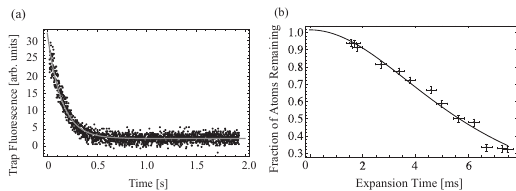
Figure 27. ( a ) Measurement of the optical molasses decay time. A fit to a decaying exponential gives a 1/ e time constant of 0.165 ± 0.002 s. ( b ) Measurement of the temperature of trapped atoms using the release and re-capture method. The vertical axis represents the fraction of re-captured atoms. The horizontal axis is the free expansion time. A determination of the most probable speed u from the fit gives a temperature T = 420 ± 20 µ